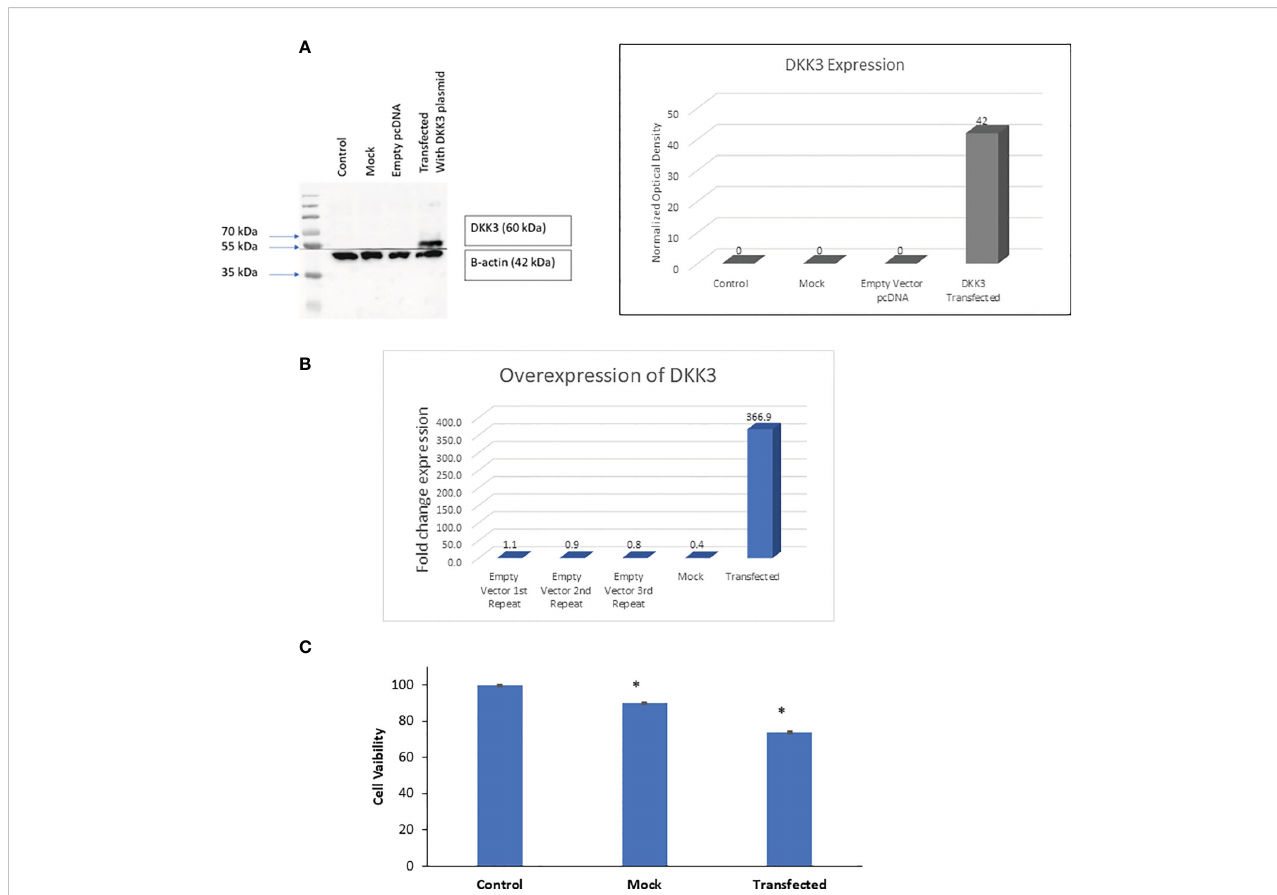
FIGURE 2 Effects of DKK3 overexpression on PC3 cell line viability. (A) Western blots of extracts from parental, MOCK, empty vector and DKK3 transfected PC3 cell line (Left panel). Densitometry analysis of DKK-3 normalized to beta-actin (Right panel). (B) Fold change expression of DKK3 expression in parental, MOCK, empty vector and DKK3 transfected PC3 cell line. (C) Cell viability of parental, MOCK, and Dkk3 transfected PC3 prostate cancer cell line, error bars show SD, Asterisk represents a signi fi cant difference (* p <